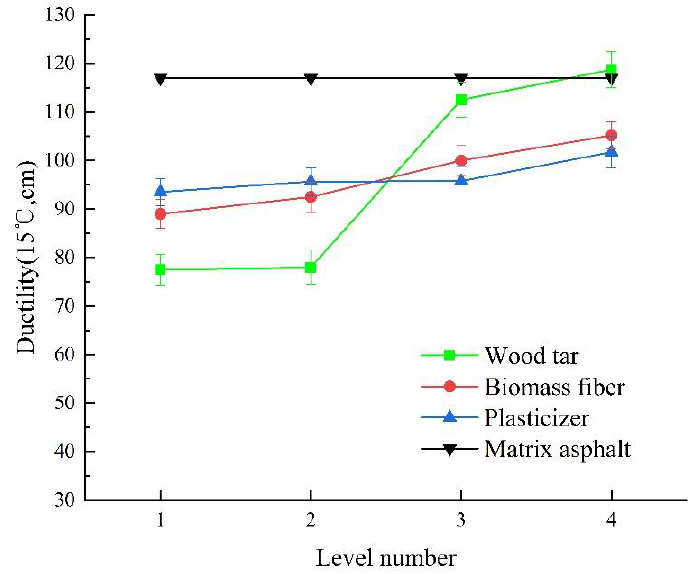
Figure 7. Change rule of ductility of wood tar-based rejuvenated asphalt under different factors and levels.